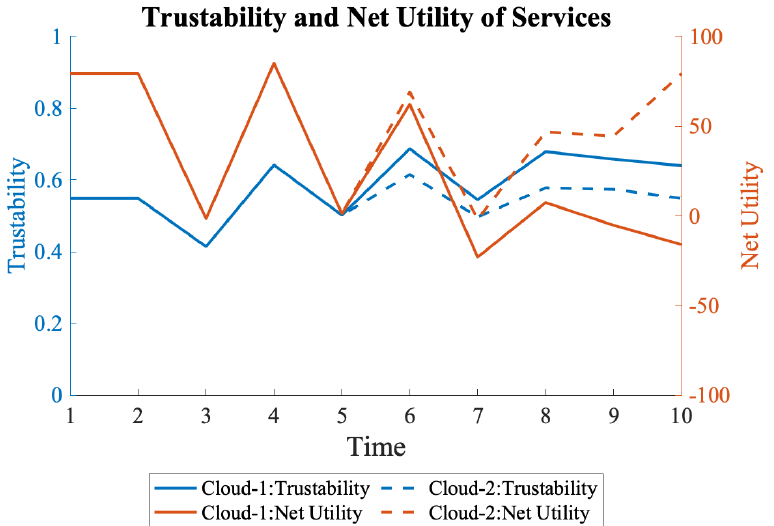
Figure 17. Trustability and net utility of Cloud-1 and Cloud-2. Cloud-1 has higher trustability but lower net utility due to more active